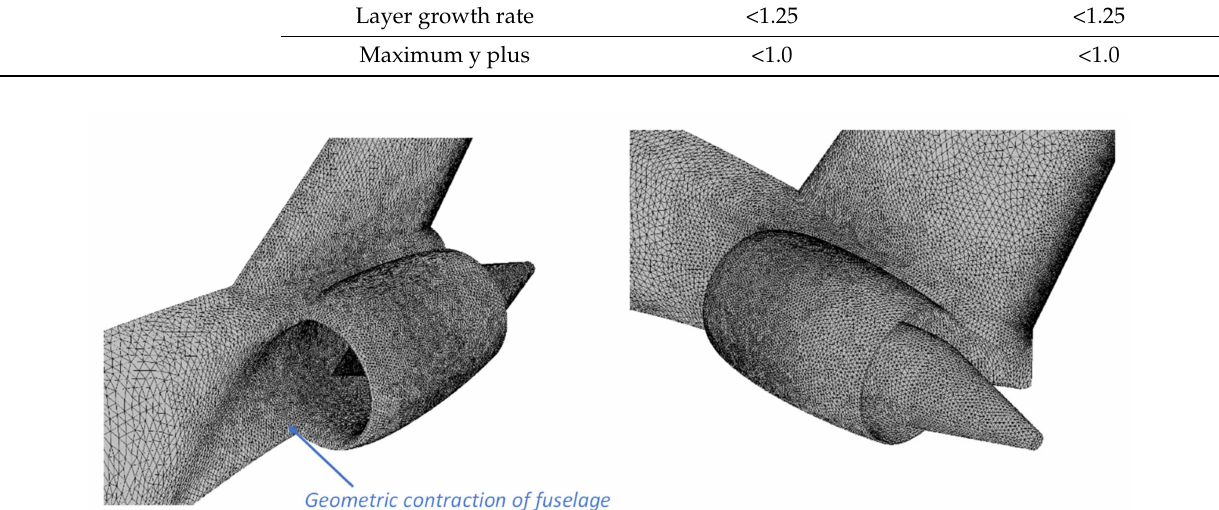
Figure 5. Typical surface mesh generated for the 3D